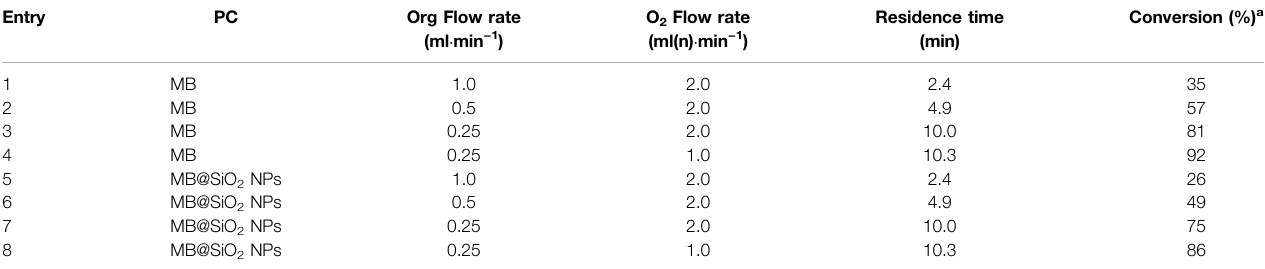
TABLE 1 | Conversions of 1 in a continuous fl ow reactor using MB and MB@SiO 2 NPs.